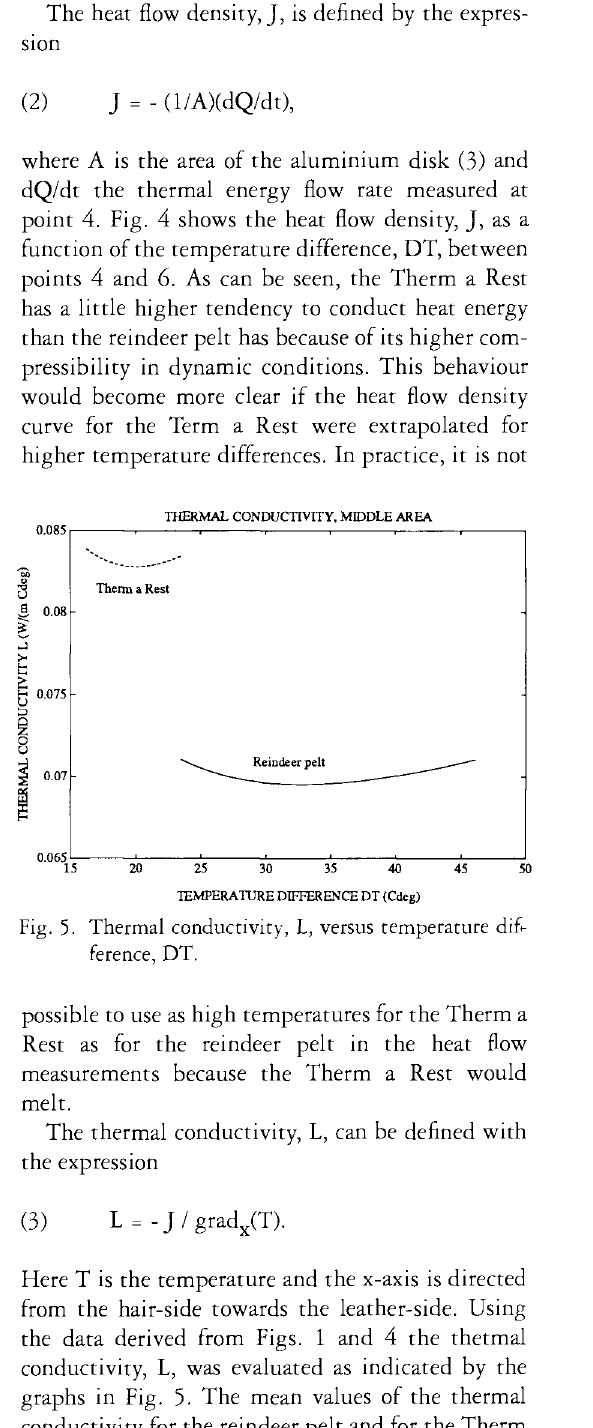
Fig. 4. Heat flow density, J, versus temperature differ ence, DT.